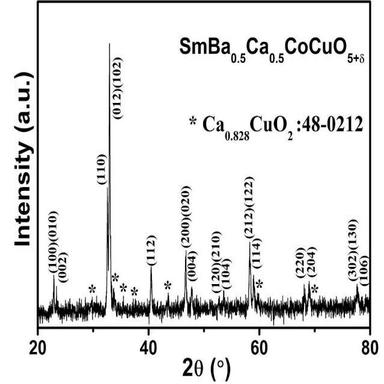
The XRD spectrum of SBCCC.